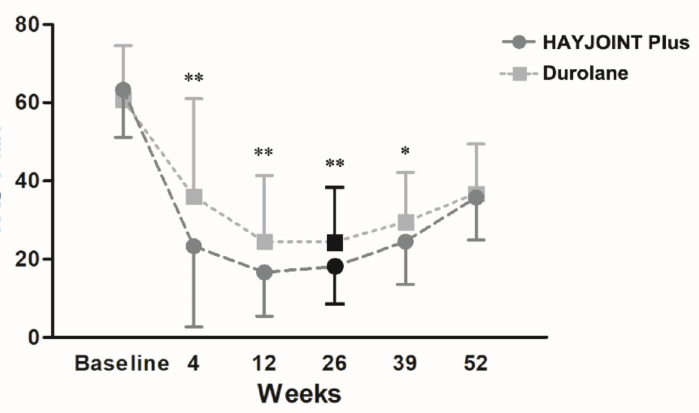
Figure 2. Changes in visual analog score (VAS) pain throughout the trial. The between-group difference * p < 0.05, ** p <